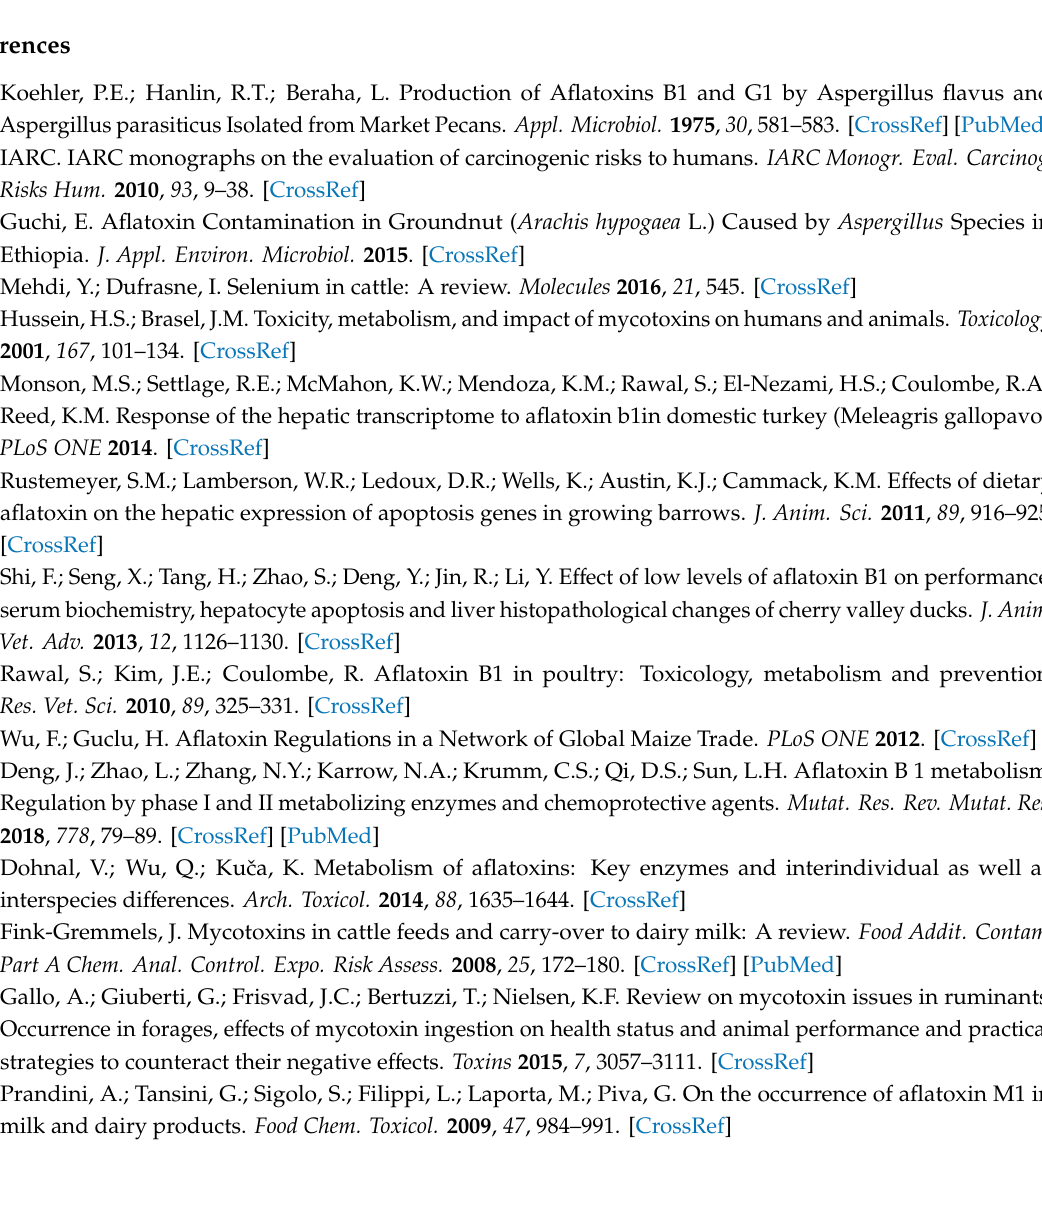
C + AFB1 vs. AFB1, Table S1: Real-time PCR assays, Table S2: Sequencing and mapping results, Table S3: Di ff erential expression analysis, Table S4: Comparison between top-10 DEGs in C vs. CTRL and CL vs. CTRL, Table S5: GO over-representation analysis, Table S6: KEGG over-representation analysis, Table S7: Gene Set Enrichment Analysis (KEGG pathways), Table S8. Overall gene expression level of the discussed genes, File S1: R